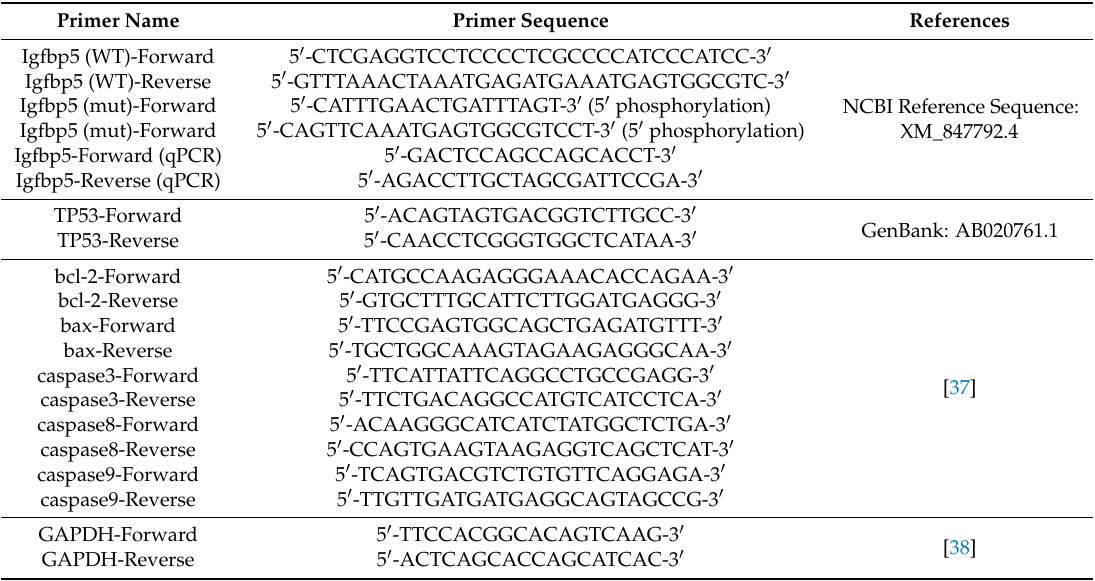
Table 1. The following primers were used in our